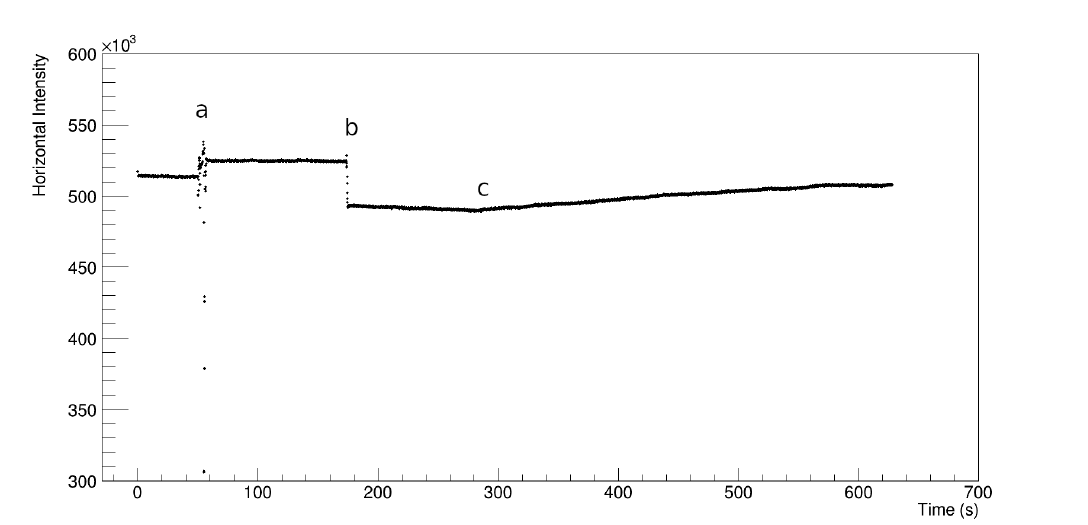
Figure 14. NanoMAX’s horizontal beam intensity. At t = 50 s ( point “a”), the MO RF is increased directly by 5 Hz. The beam intensity decreases abruptly and significantly before rising again, as a result of MO RF increase. At t = 174 s ( point “b”), the MO RF is decreased by 10 Hz directly, and, once more, a large disturbance in the delivered beam for NanoMAX is observed. At 285 s ( point “c”), the MO RF starts to be increased towards a total 5 Hz change using the sweeper. The effect is observable as a subtle drop in the horizontal intensity at the recorded change time, which starts increasing again during the approximate 5 min it takes the MO RF to reach its new desired